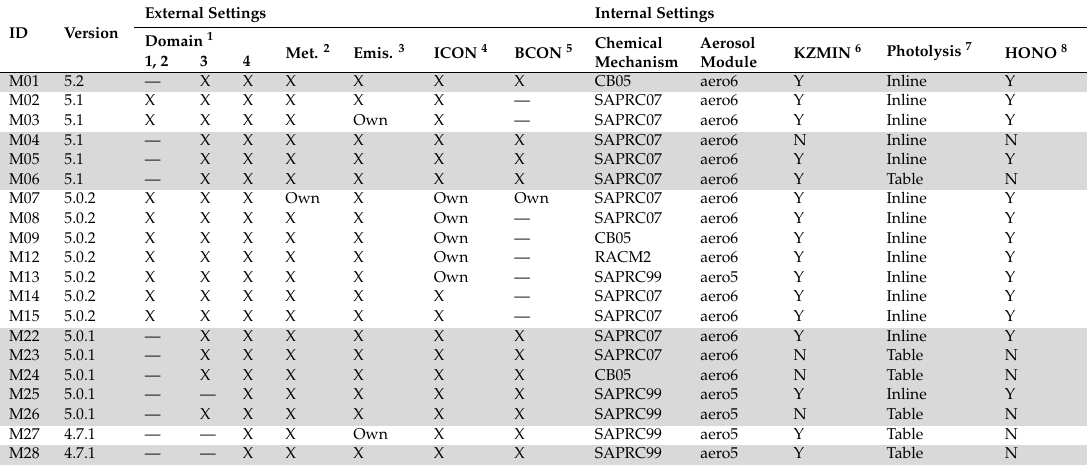
1 Domain: “X” indicates the domain in which the participant conducted their simulation. “—” indicates that the participant did not conduct their simulation over domains 1 and 2, and they used the common dataset for the simulation of domains 3 and / or 4; these models are shaded in grey. 2 Meteorological field: “X” indicates that the common metrological input data were used. “Own” indicates their own meteorological data were used; M07 used WRF with di ff erent settings. 3 Emission data: “X” indicates the common emission input data were used. “Own” indicates their own dataset was used; see text for details. 4 Initial conditions: “X” indicates the common initial condition was used. “Own” indicates their own data were used; see text for details. 5 Boundary condition: “X” indicates the common boundary condition was used. ”—” indicates the common dataset was not used because the participant conducted their simulation from domain 1. “Own” indicates their own dataset was used; M07 used a di ff erent global model for the boundary condition of domain 1; see text for details. 6 Option in CMAQ for minimum vertical di ff usion coe ffi cients: “Y” indicates the KZMIN method was used, and “N” indicates the KZMIN method was not used. 7 Option in CMAQ for the calculation of photolysis rate: “Inline” indicates an inline calculation was used, and “Table” indicates a lookup table was used. 8 Option in CMAQ for the production of HONO from the heterogeneous reaction on the ground surface: “Y” indicates this option was switched on, and “N” indicates this option was switched o ff